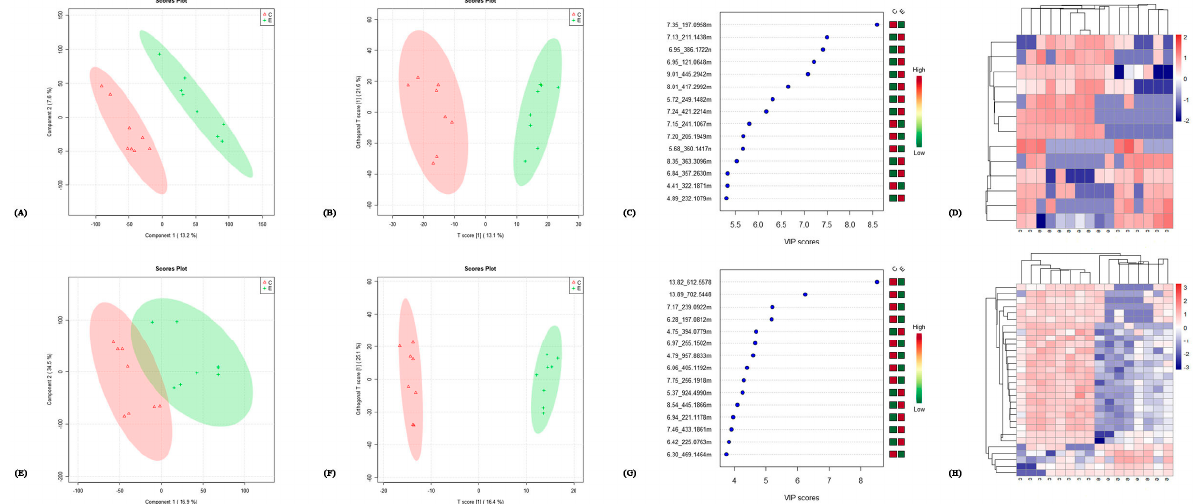
Figure. 3 PLS-DA, OPLS-DA, VIP scores and cluster diagram analysis results taking E/C as an example